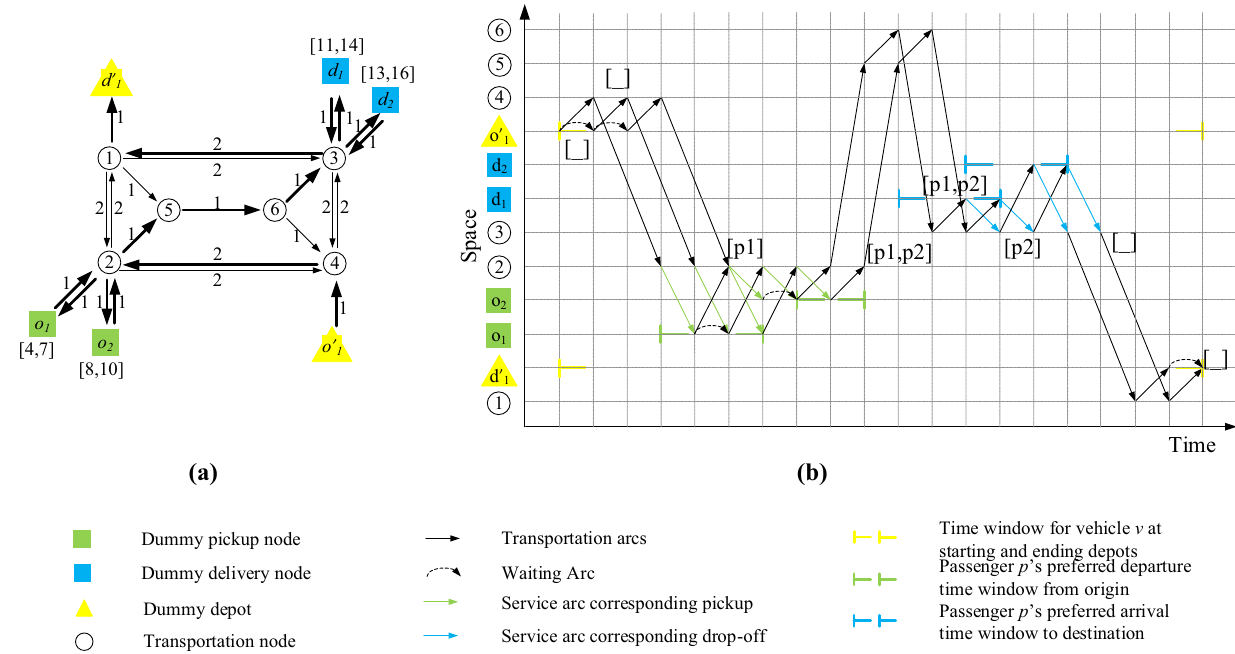
Fig. 1 a Six-node transportation network, transportation network with the corresponding dummy nodes, where [ • , • ] represents passenger time windows; b shortest paths in the space–time network, where [], [p1], [p1] and [p1, p2] represent vehicle carrying states